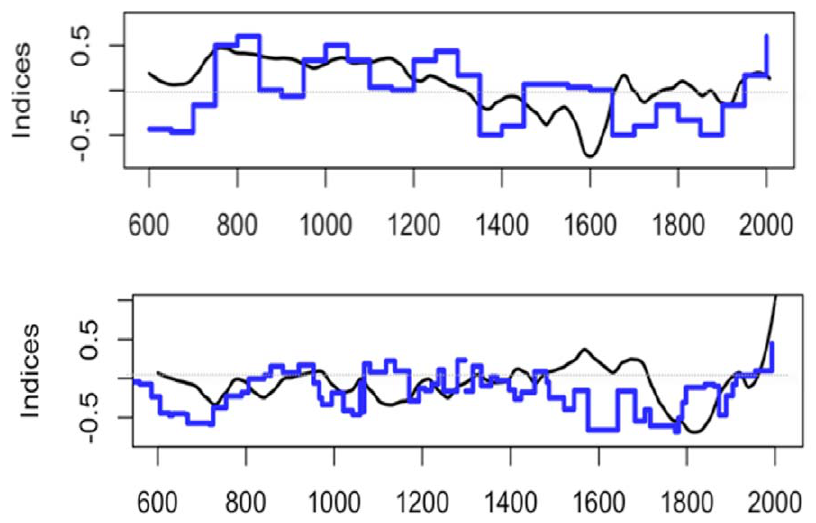
Figure 5. Comparison of the reconstructions and glacier curves. In black, the smoothed April-September temperature of the [7.5 u E, 47.5 u N] and [2.5 u E, 62.5 u N] grid-points and in blue, the advance and retreat glacier curve of respectively Aletsch glacier and group of Scandinavian glaciers [22,23]. The temperature curves are in u C (anomalies) and the glacier curves in dimensionless units.